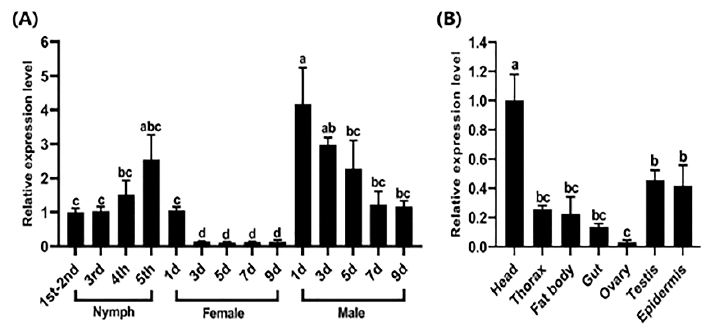
Figure 3. Spatiotemporal expression patterns of Cpr21L . ( A ) Expression patterns of Cpr21L in BPHs at different developmental stages. Samples were collected from nymphs (1st–5th instar), females, and males (1, 3, 5, 7, and 9 days post-eclosion). ( B ) Expression patterns of Cpr21L in different tissues or body parts. RPS11 was used as the reference gene to normalize gene expression. Bars are the mean ± SEM (standard error of mean) from three independent experiments. The data were analyzed by one-way ANOVA and Tukey’s multiple comparison tests. Different letters "a", "b", and "c" on the bars indicate significant differences ( p < 0.05), while the same letter were not significantly different (P < 0.05)..